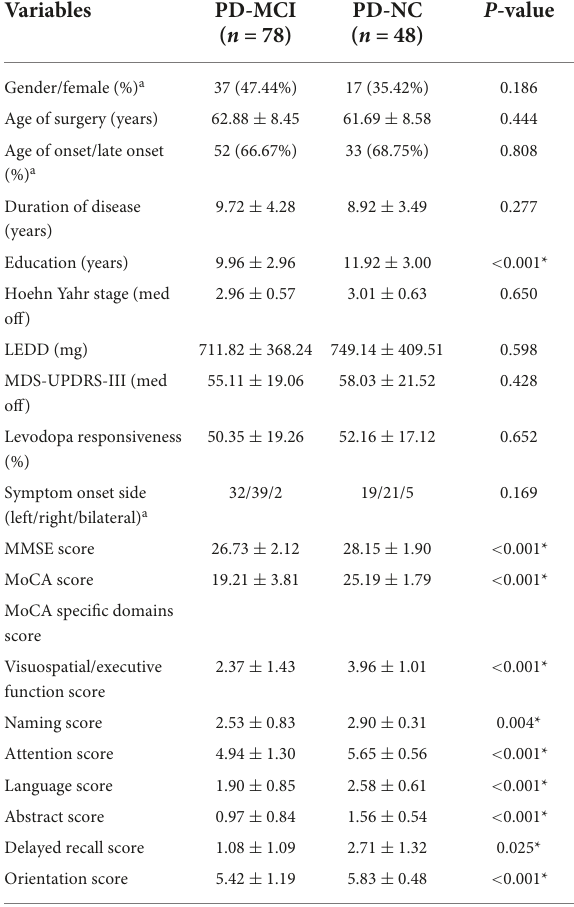
TABLE 1 Baseline characteristics and clinical information of PD patients with MCI and